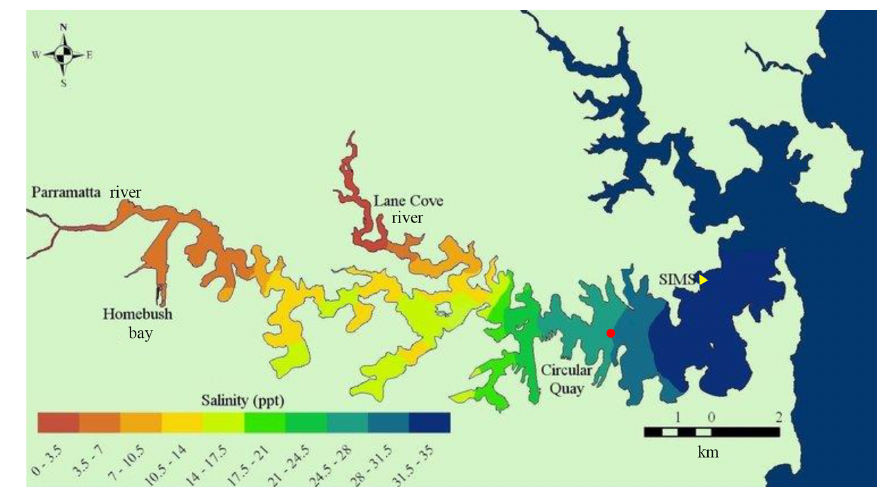
Figure 1. Port Jackson (Sydney Harbour) with sampling site (SIMS, yellow triangle) and Fort Denison tide reference station (red circle). The red dot on the map indicates Sydney’s location. Map courtesy of Ian Jones and Daniel Harrison (http://www.sydneyharbourobservatory.org/ projects-1/, last access: 6 July 2018).